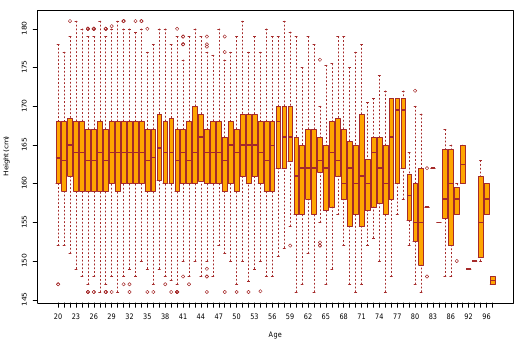
Figure 10. Box plot of data explaining the 1st and 3rd quantile of male height showing the range of height for each